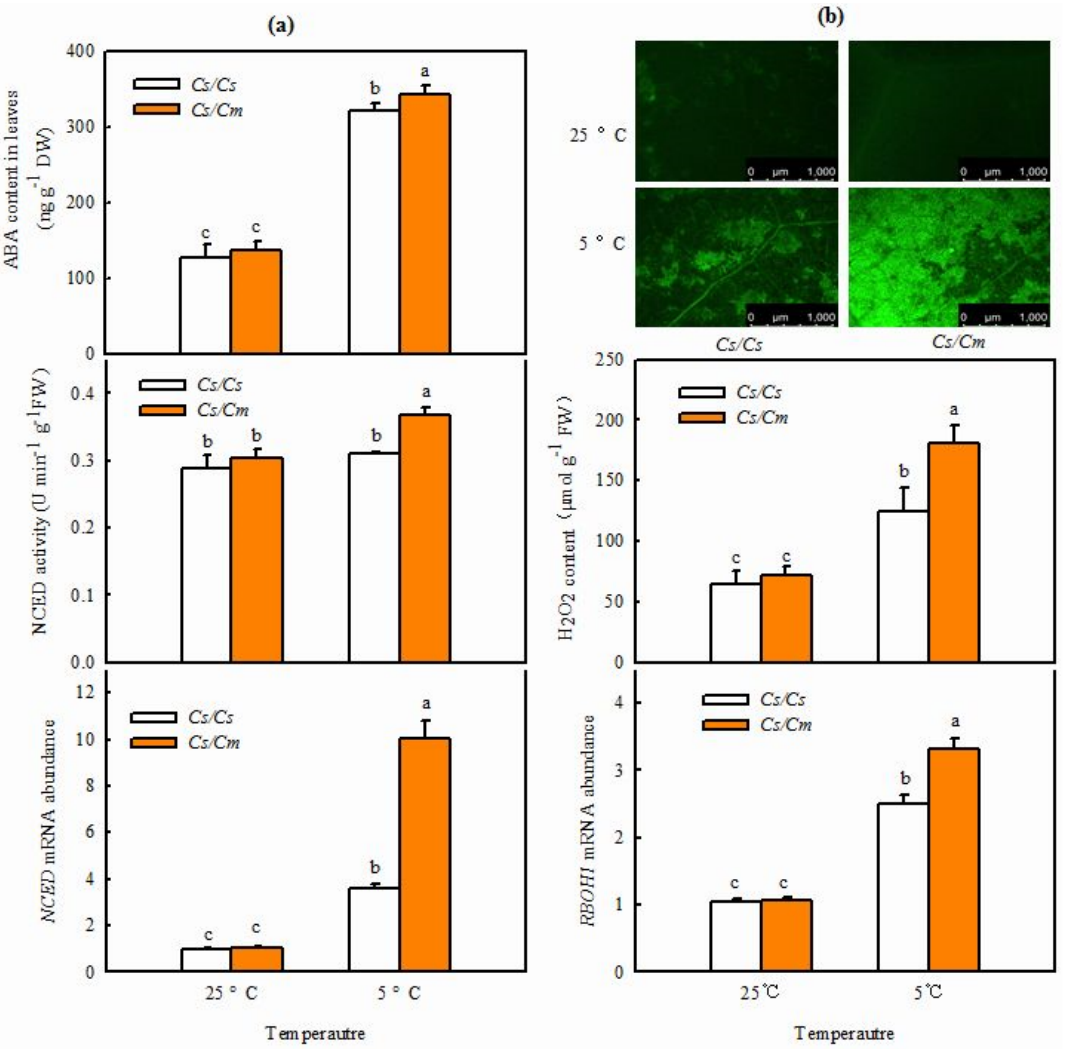
Figure 2. Accumulation of ABA and H 2 O 2 in leaves of grafted or self − grafted cucumber plants. ( a ) ABA content, NCED activity, and its mRNA abundance, respectively. The plants were treated at 5 ◦ C for 0 h and 12 h. ( b ) H 2 O 2 accumulation and RBOH1 mRNA abundance, respectively. The plants were treated at 5 ◦ C for 0 h and 6 h. Data are presented as the means ± SD ( n = 3). Different letters indicate a statistical significance between samples at p < 0.05.